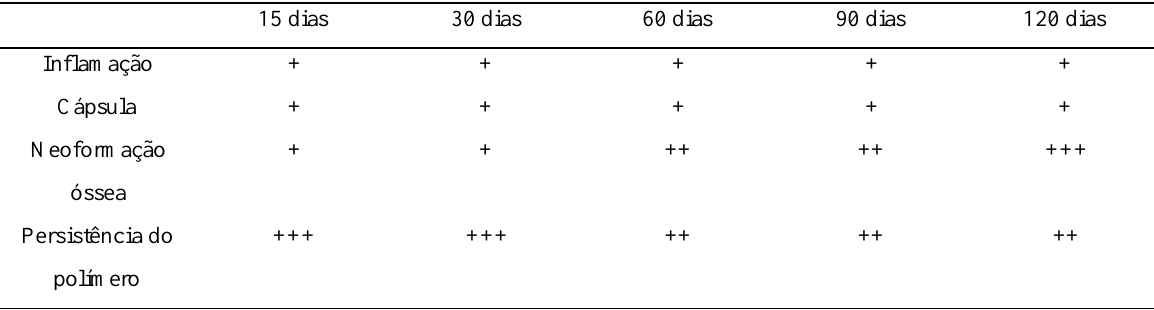
TABELA 1 - Avaliação dos parâmetros histológicos utilizados para a determinação da eficácia do polímero de mamona na neoformação